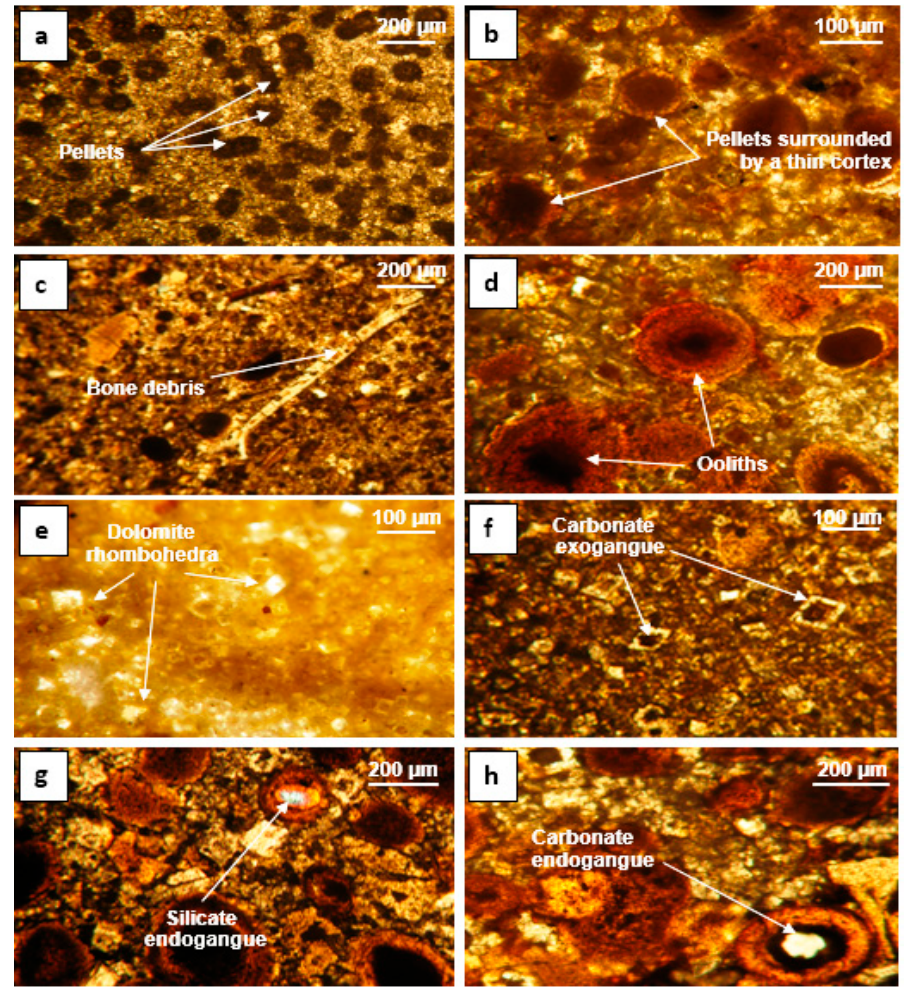
Figure 1. Optical microscope observation (plane polarized light) of the roof phosphates of the Tozeur-Nefta deposit. ( a ) Pellets of rounded to sub-rounded shapes bound by a microsparitic cement; ( b ) Pellets surrounded by a thin clear cortex; ( c ) Bone debris of elongated forms; ( d ) Oolites formed by the deposition of successive micrometric layers of phosphate; ( e ) Carbonate bonding phase formed by euhedral dolomite; ( f ) Carbonate exogangue made of euhedral dolomite; ( g ) Silicate (quartz) endogangue making the nucleus of the phosphate grain; ( h ) Carbonate (calcite) endogangue making the nucleus of the phosphate